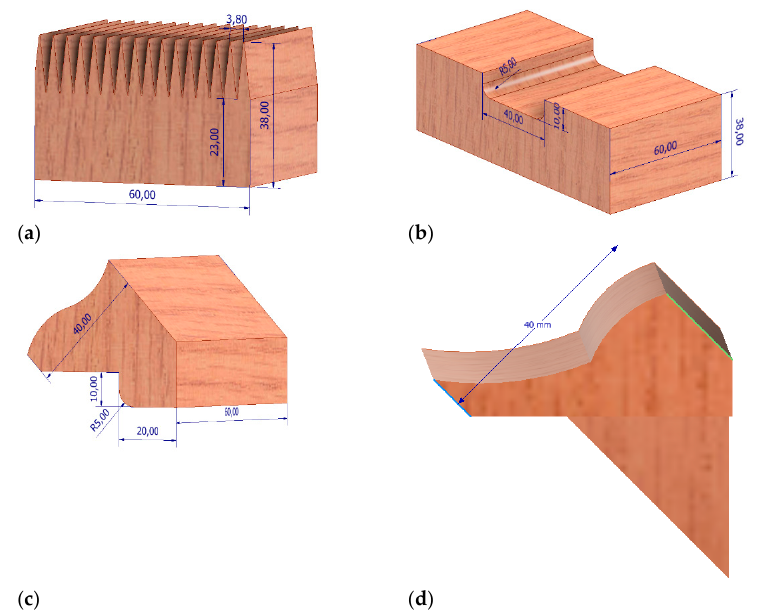
Figure 5. From the left: finger joint—chord of truss, UPP2 ( a ); tenon joint—chord of truss, tenon joint fragment of the lower belt UPP1 ( b ); tenon joint—diagonal member, tenon joint fragment of the crossbone UPP1 ( c ), tenon joint—diagonal member, tenon joint fragment of the crossbone UPP3 ( d ).